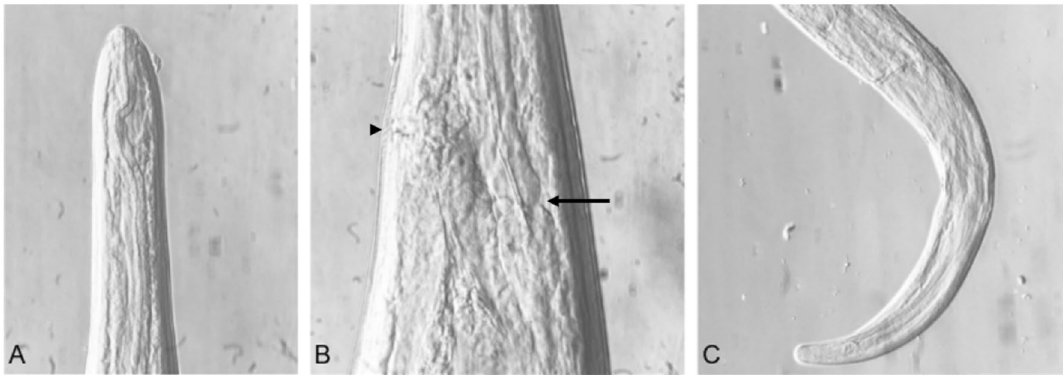
Figure 5. ( A ) Anterior extremity of a female specimen from hare-1 (×100), ( B ) Joint zone of the oesophagus with the intestine (arrow) and vulva (arrow head), female, hare-1 (×200), ( C ) Posterior extremity of a female specimen, hare-1.